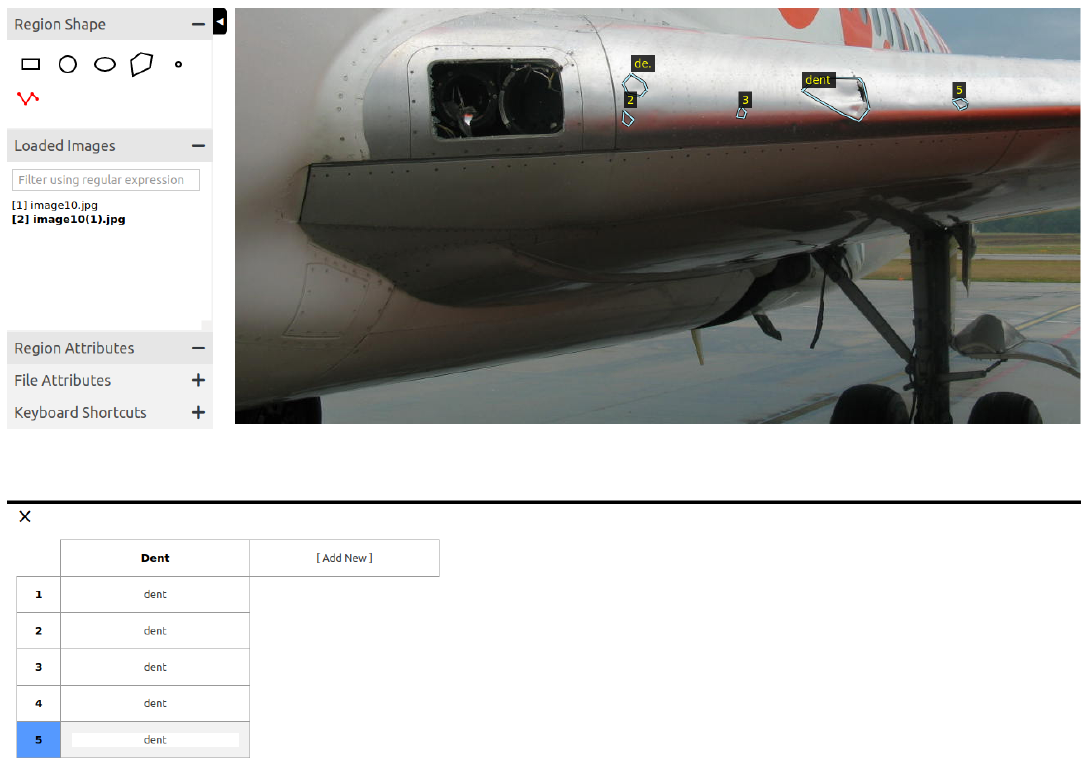
Figure 8. Manual dent annotation.